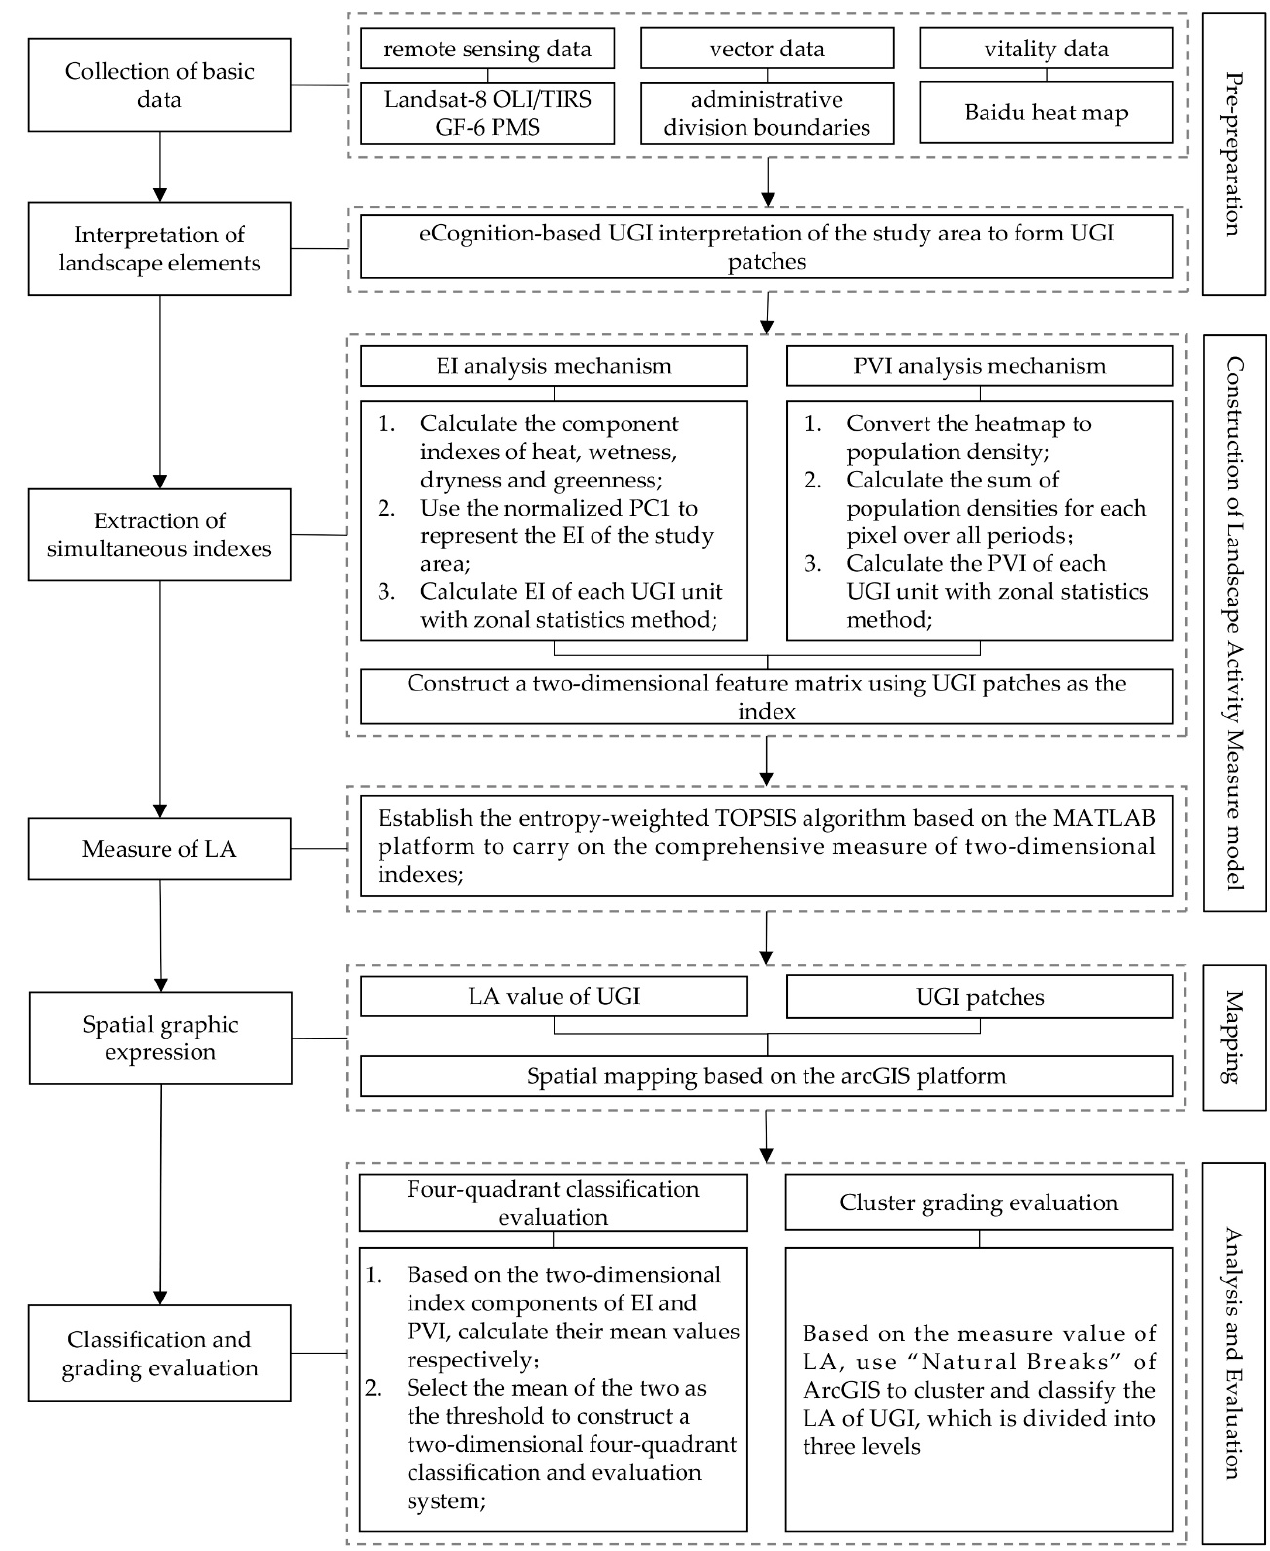
Figure 1. UGI landscape activity measure research framework integrating the ecological index and public vitality